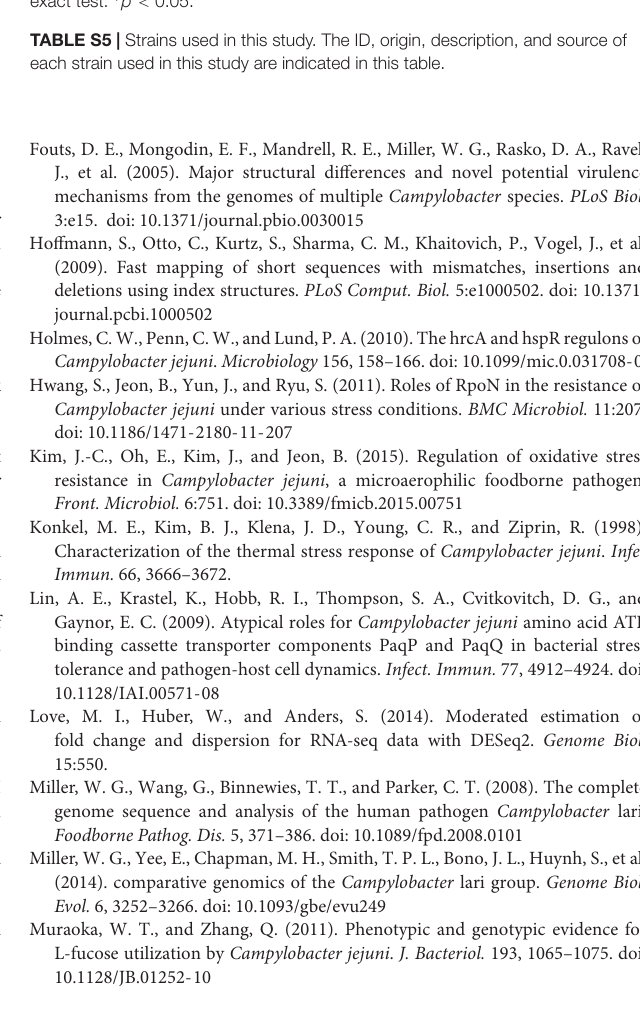
TABLE S1 | Primers used in this study. The target gene, primer sequence and concentration, the amplicon length, and annealing temperature of each primer used for qRT-PCR for both strains are indicated in this table. TABLE S2 | Mapping statistics for all libraries in the RNA-seq. This table indicates the total number of sequenced cDNA reads considered in the analysis and used for alignment, the total number of aligned and of uniquely aligned reads, the total number of alignments, and the percentage of aligned and uniquely aligned reads for the replicates at 37 and 46 ◦ C for both strains. TABLE S3 | Excel file containing the Orthologs of differentially regulated genes after heat stress in C. coli RM2228 and C. lari RM2100. All genes for which a